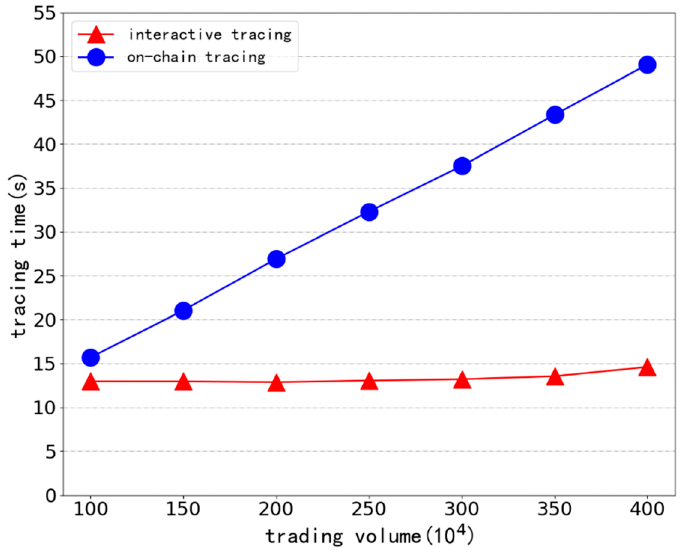
Figure 6. Comparison of the efficiency of interactive traceability structures supporting type filtering with traditional traceability.